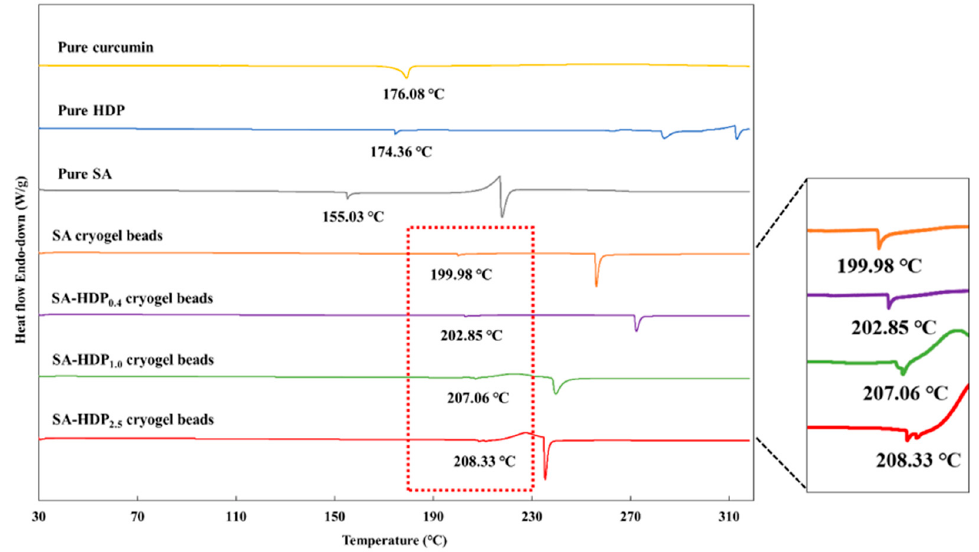
Figure 3. Differential scanning calorimetry (DSC) analyses of pure curcumin, pure hydroxypropyl distarch phosphate (HDP), pure sodium alginate (SA), and SA-based cryogel beads filled with different concentrations of HDP. SA cryogel beads, SA-HDP 0.4 cryogel beads, SA-HDP 1.0 cryogel beads, and SA-HDP 2.5 cryogel beads represent cryogel beads filled with different concentrations of HDP (0, 0.4, 1.0, and 2.5%, respectively).